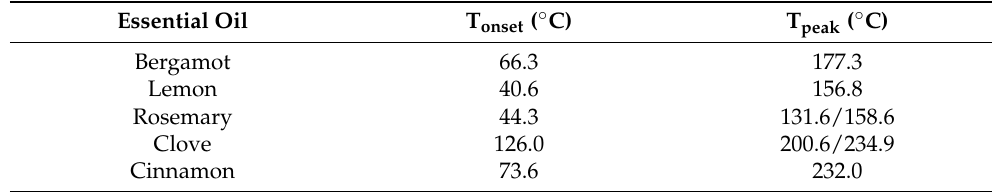
Figure 1. TG and DTG (in the inset) traces of bergamot, lemon, rosemary, clove and cinnamon oils, recorded in the range of 30–800 °C in an air-saturated atmosphere. Table 3. T onset and T peak of bergamot, lemon, rosemary, clove and cinnamon oils obtained by TGA. Essential